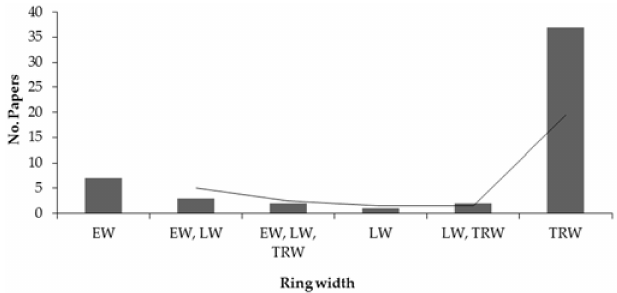
Figure 9. Dendrochronological studies performed in Mexico considering measurements of the width of earlywood (EW), latewood (LW) and total ring width (TRW).